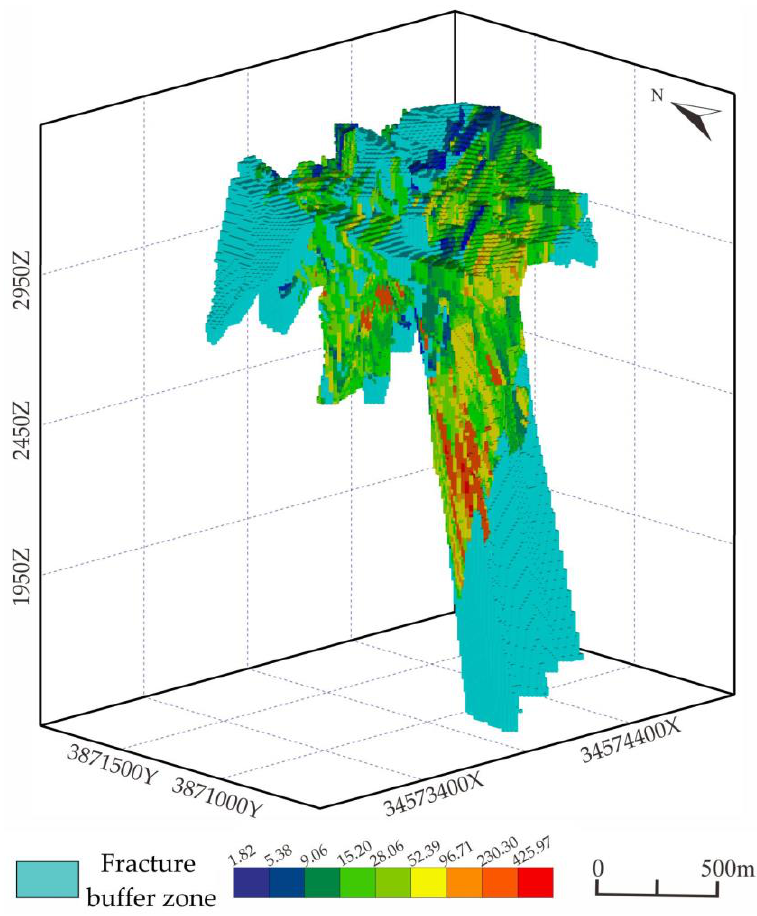
Figure 16. Spatial distribution of As-Sb-Hg(B1)/W-Bi-Co-Mo(B3). Table 3. Geological and geochemical quantitative mineral resource prediction model at depth of Zaozigou gold deposit.